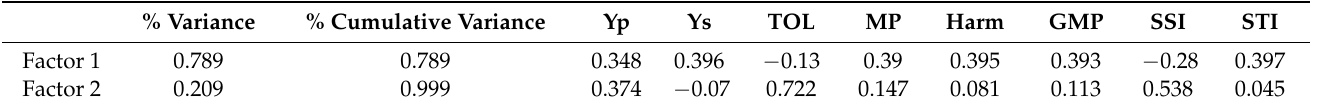
Table 7. Principal components analysis for average grain yield under normal conditions and moisture stress and drought-tolerance indices.